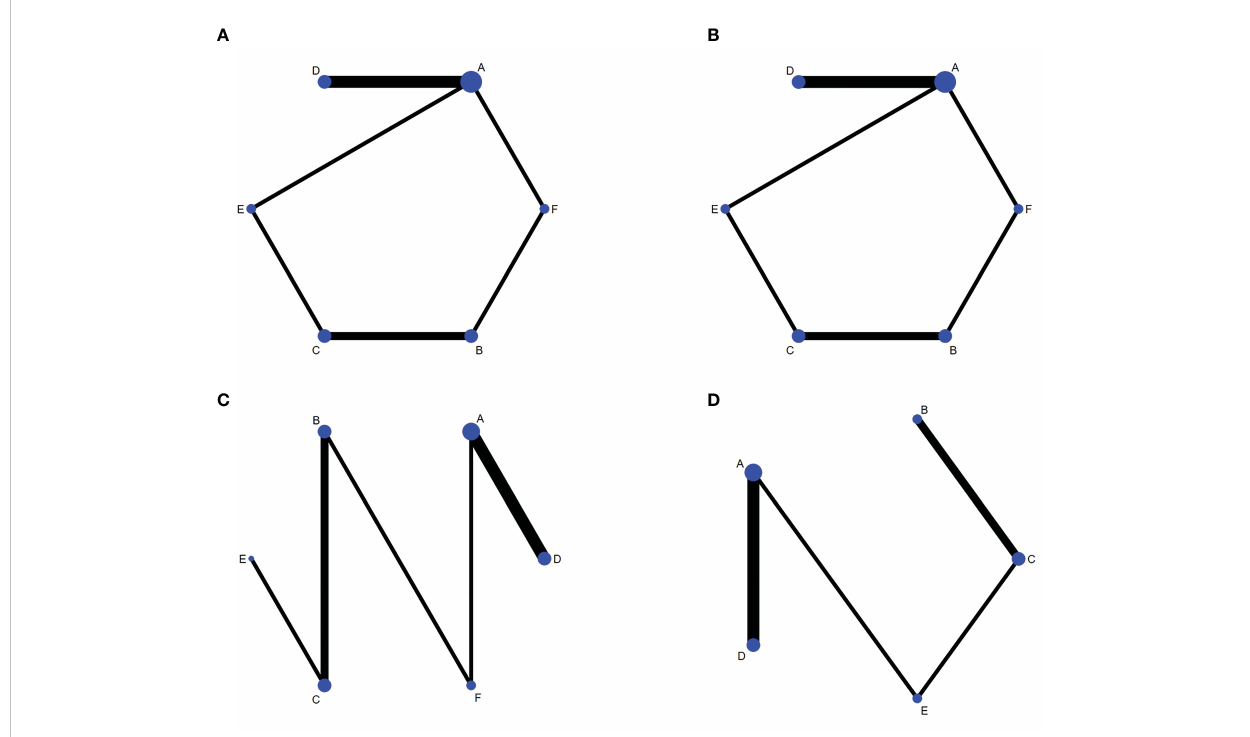
FIGURE 3 Network diagrams of outcome indicators. (A) good response rate; (B) complete response rate; (C) percent change form baseline in SALT scorer; (D) TEAE (treatment emergent adverse events) rate. A: placebo treatment B: conventional steroid therapy C: any dose of oral tofacitinib treatment D: any dose of oral baricitinib treatment E: any dose of oral ruxolitinib treatment F: nonoral JAK inhibitor